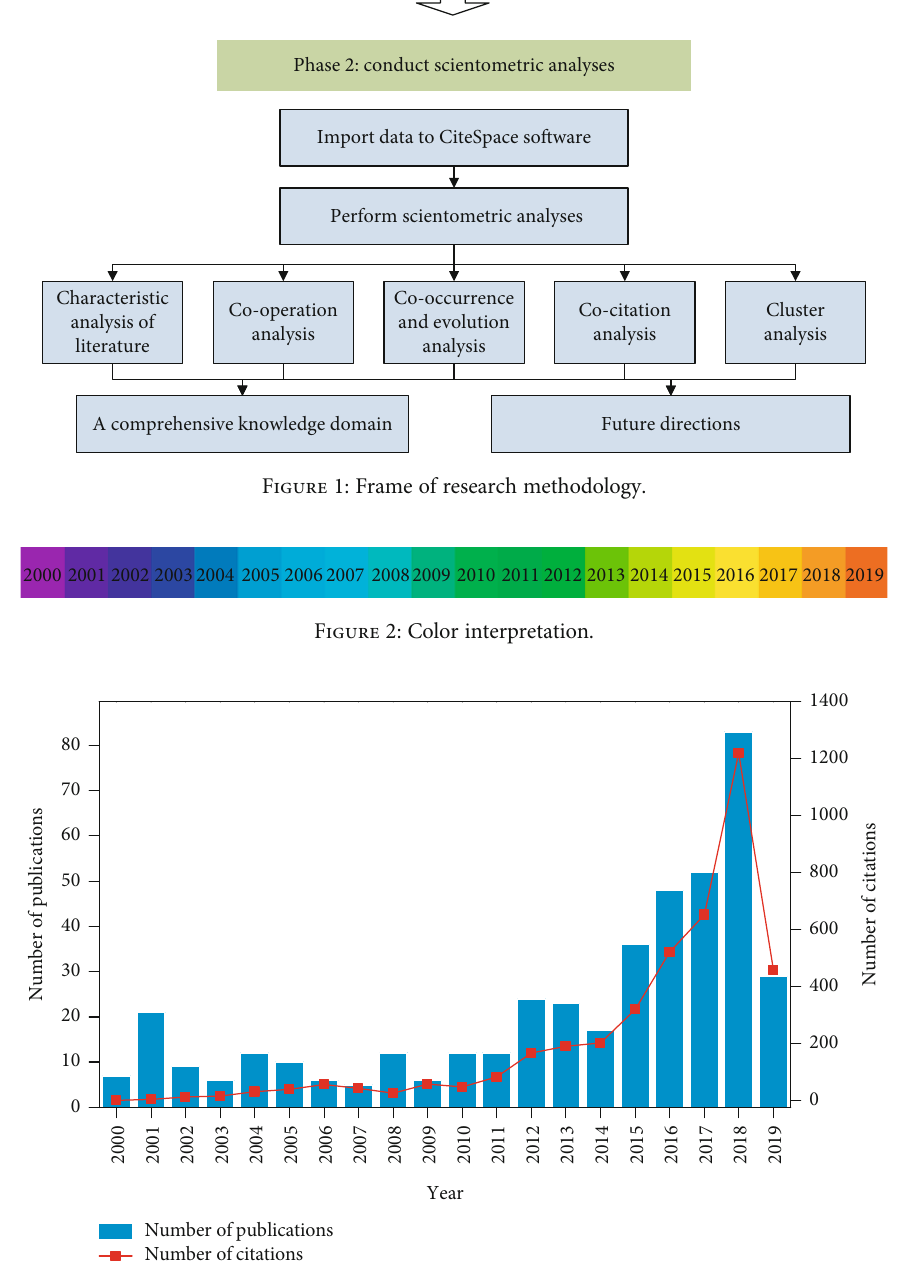
Figure 3: Number of publications and citations from 2000 to